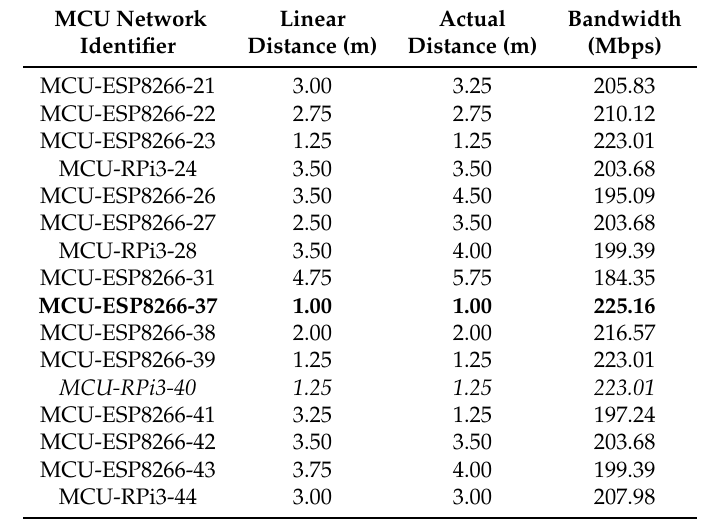
= 16 MCU i ( t 0 ) devices that have a stable link with the wireless access point (WAP) Table 2. List of the ∑ β i = 1 in Mbps inside the WSN N ( t 0 ) network. The highest linked node is in bold and the second highest linked in